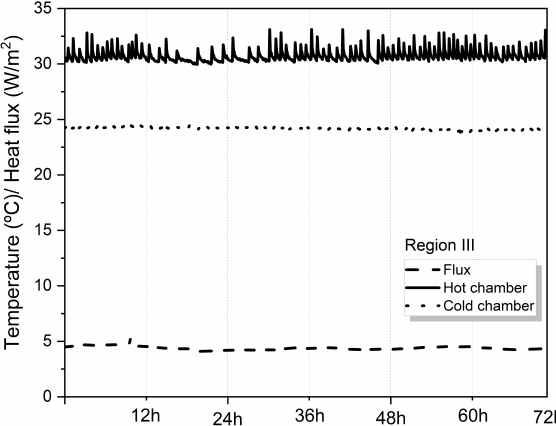
Figure 7. Region III reed board prototype: tempera- tures and heat